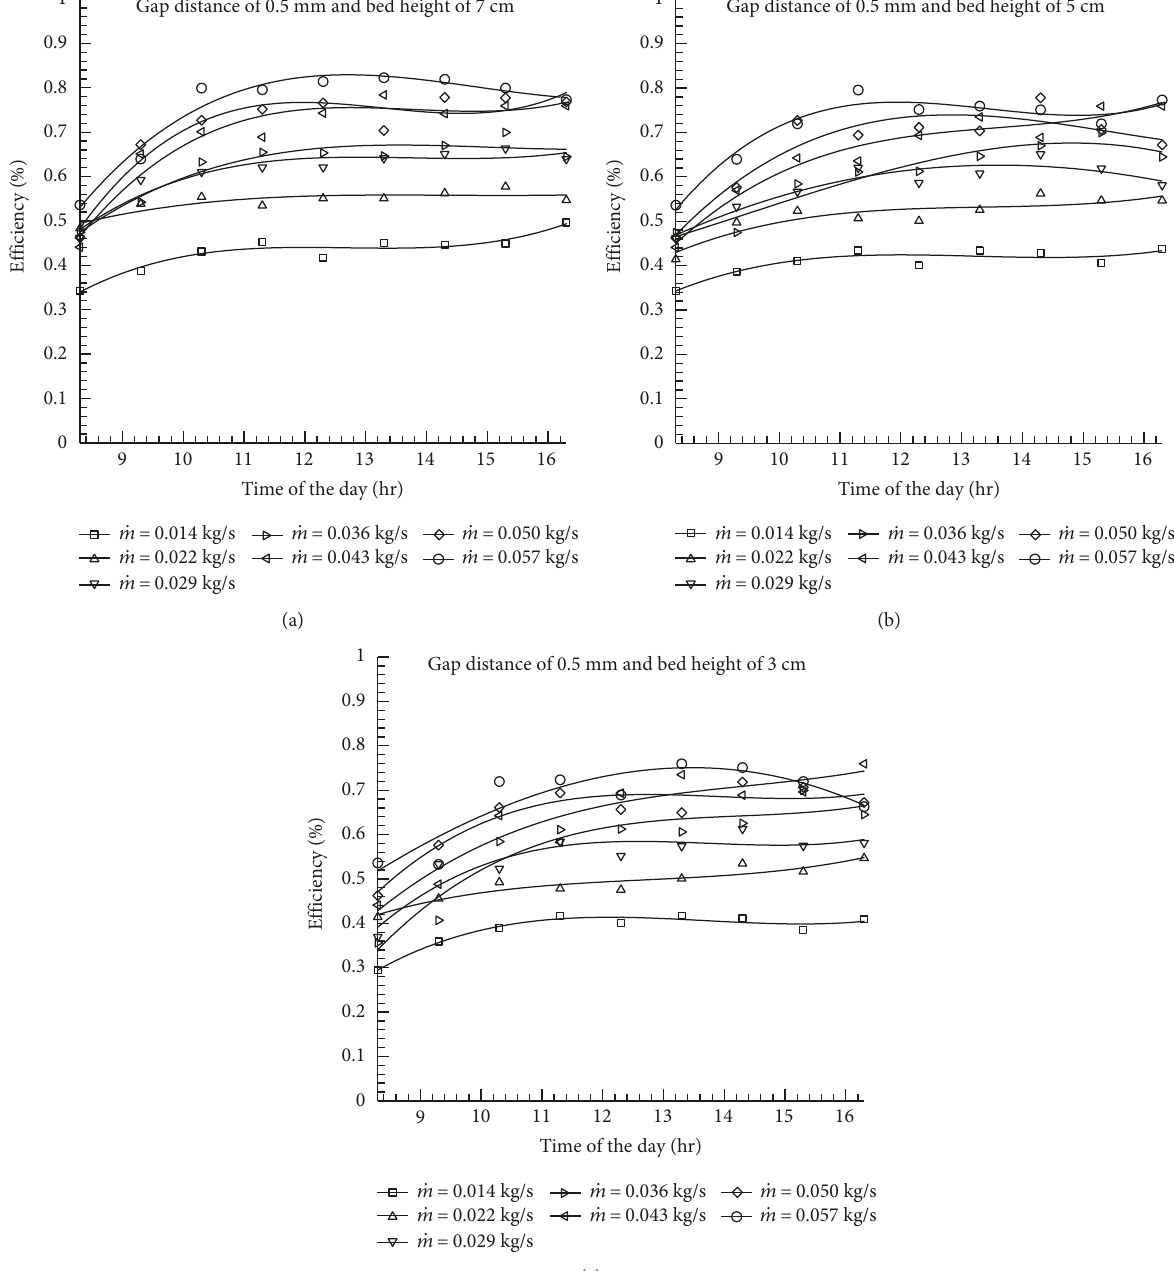
Figure 8: Thermal e ffi ciency versus time at the gap distance of 0.5 mm for bed heights (a) 7cm, (b) 5 cm, and (c) 3cm and di ff erent mass fl ux